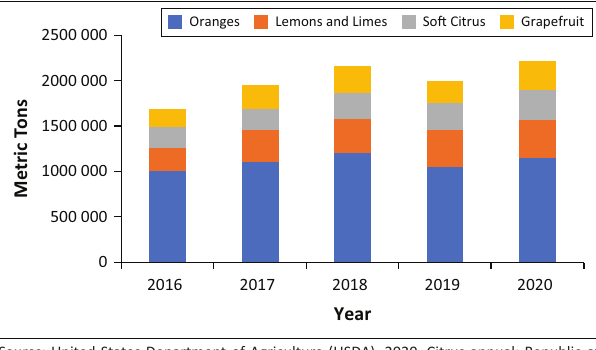
FIGURE 1: Market segmentation of the South African fruit industry.